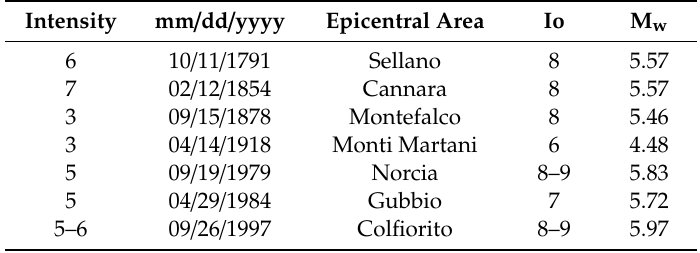
Table 1. Extract of the Parametric Catalog of Italian Earthquakes for the Perugia district from the 18th century to the present day. The information reported for each seismic event are: Intensity expressed in the Mercalli scale; Io—Epicentral intensity; M w —Moment magnitude calculated on the entire seismograms starting from the estimate of the geometric feature of the fault (for further details please check the I.N.G.V web